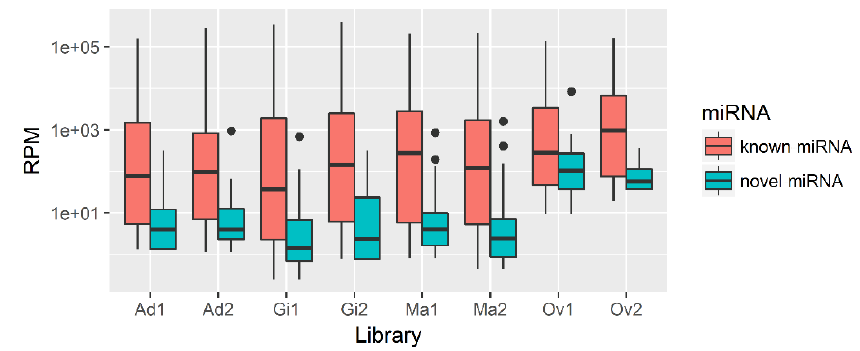
Figure 2. Expression density of known and novel microRNAs (miRNAs) in P. fucata . Ad: adductor muscle; Gi: gill; Ma: mantle; Ov: ovary.